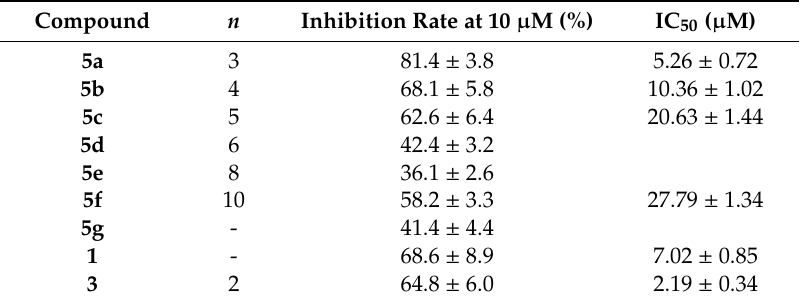
Table 2. The enzyme inhibition of Series Ⅱ compounds.